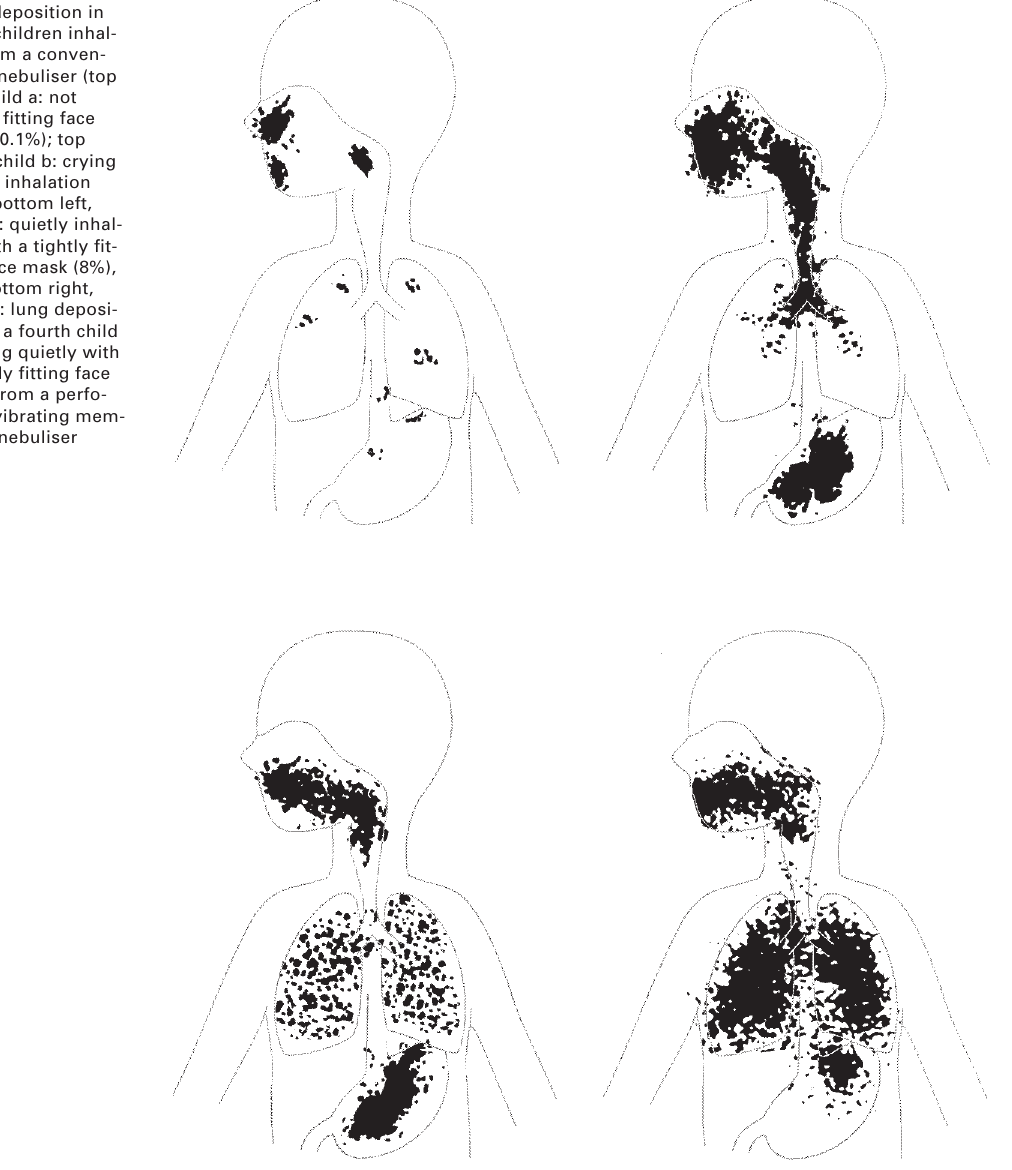
Lung deposition in three children inhal- ing from a conven- tional nebuliser (top left, child a: not tightly fitting face mask (0.1%); top right, child b: crying during inhalation (1%); bottom left, child c: quietly inhal- ing with a tightly fit- ting face mask (8%), and bottom right, child e: lung deposi- tion in a fourth child inhaling quietly with a tightly fitting face mask from a perfo- rated vibrating mem- brane nebuliser